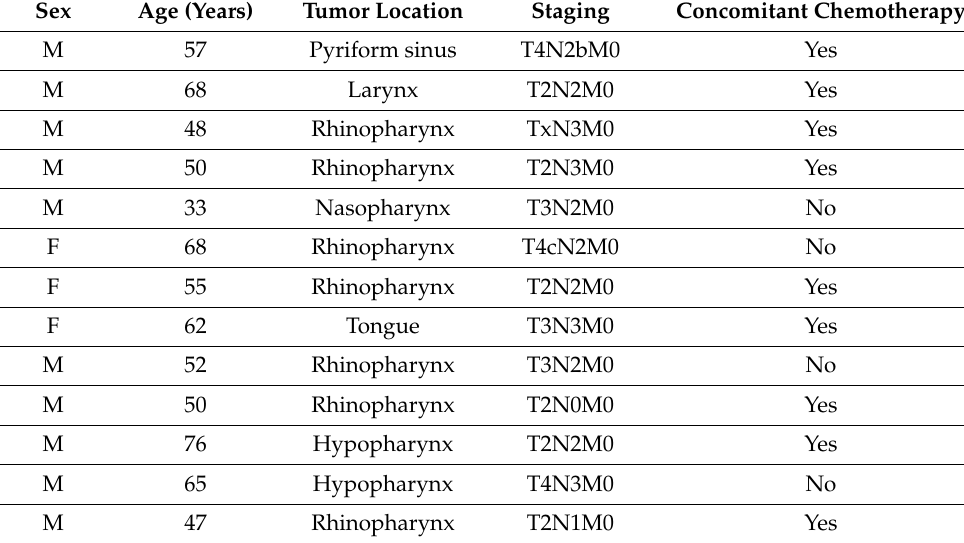
Table 1. Patient